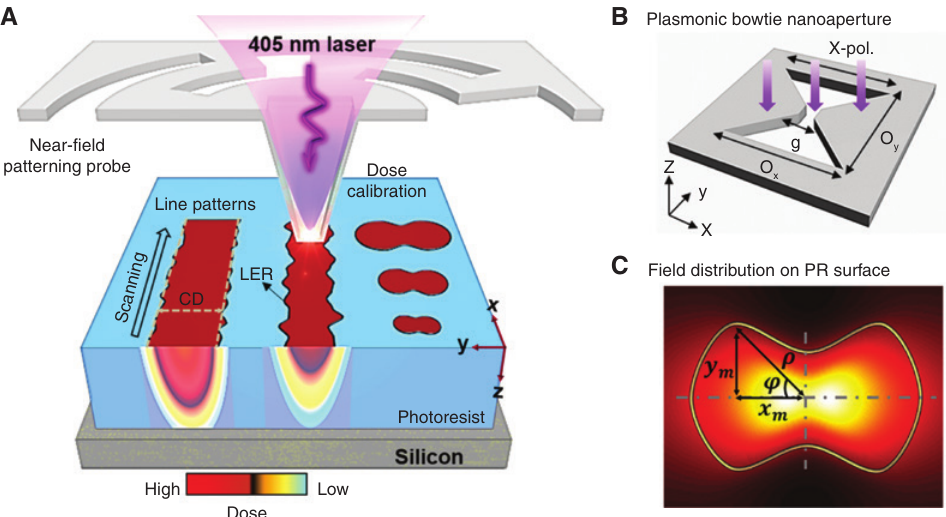
Figure 1: Schematics of the near-field patterning process using a scanning plasmonic BNA. (A) Dose calibration using spot-mapping patterns to extract the decay characteristics of the evanescent field. LER analysis of the line patterns was carried out with different CDs by adjusting the exposure-dose distributions on the photoresist surface. The optical source, which is a linearly x -polarized laser with 405 nm wavelength, is incident on a metallic BNA. (B) Geometry of a plasmonic BNA, which is perforated at the = O = 150 nm with various ridge-gap sizes ( g ) from 10 to 30 nm. tip apex of the near-field patterning probe in (A). The outline dimension is O x y (C) Calculated field distribution excited by a plasmonic BNA on the photoresist surface and geometry of the photoresist